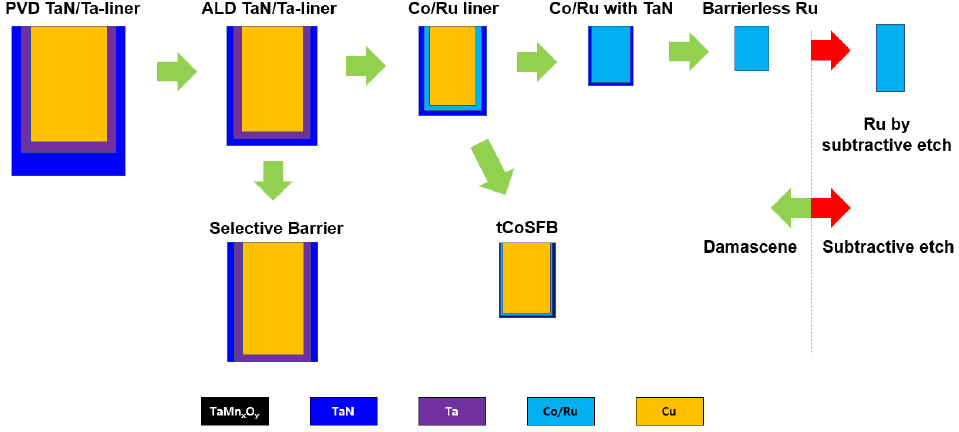
Figure 12. Trends in recent metallization approaches.